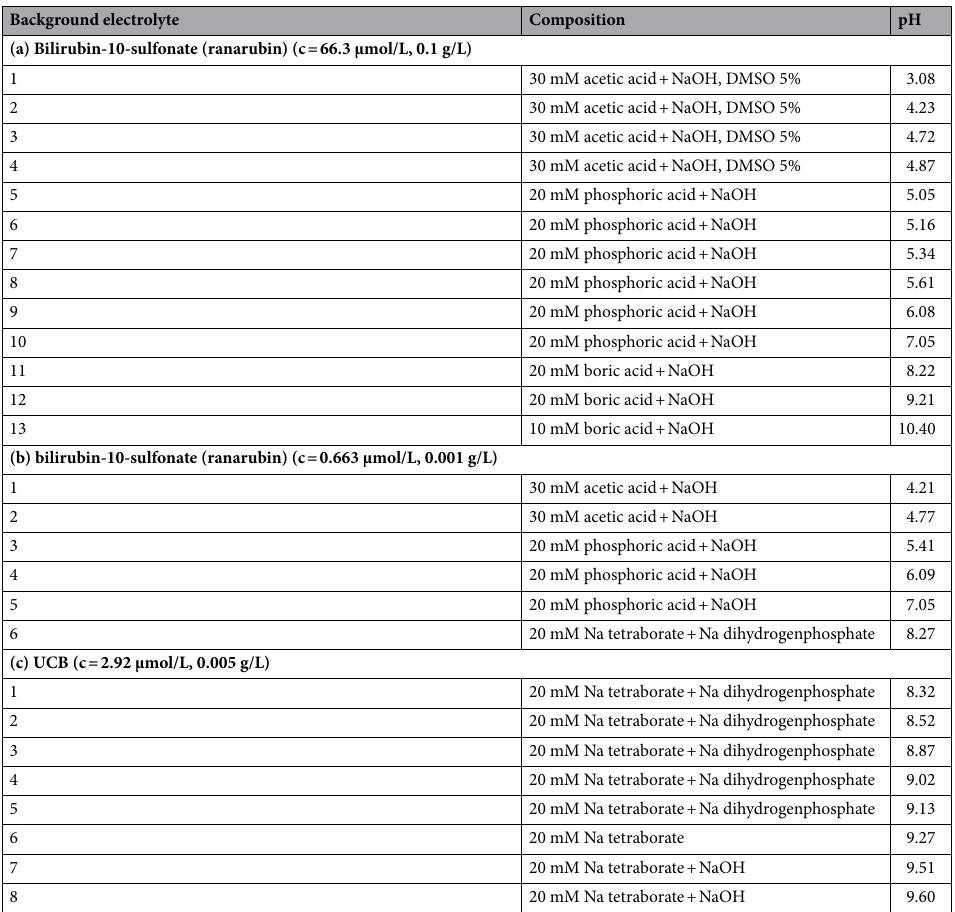
Table 1. Background electrolytes used for capillary